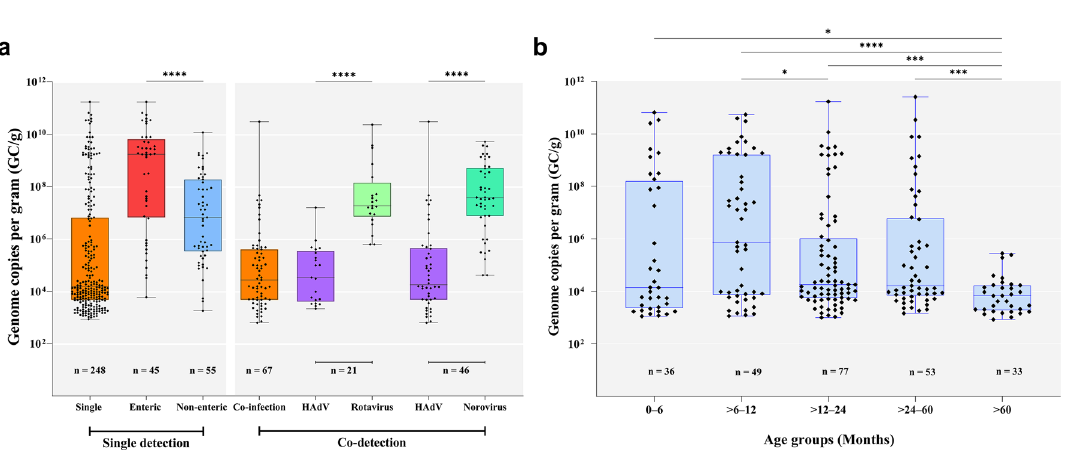
Figure 4. (a) Enteric viruses viral load expressed as genome copies per gram of stool (GC/g). Among HAdV single- and co-detected samples with rotavirus and norovirus. (b) HAdV single-detections viral load among different age groups in Brazil, 2018–2020. Box-and-whisker plots show the first and third quartiles (equivalent to the 5th and 95th percentiles), the median (the horizontal line in the box), and range of HAdV viral load concentrations. * p ≤ 0.05; *** p ≤ 0.001; **** p ≤